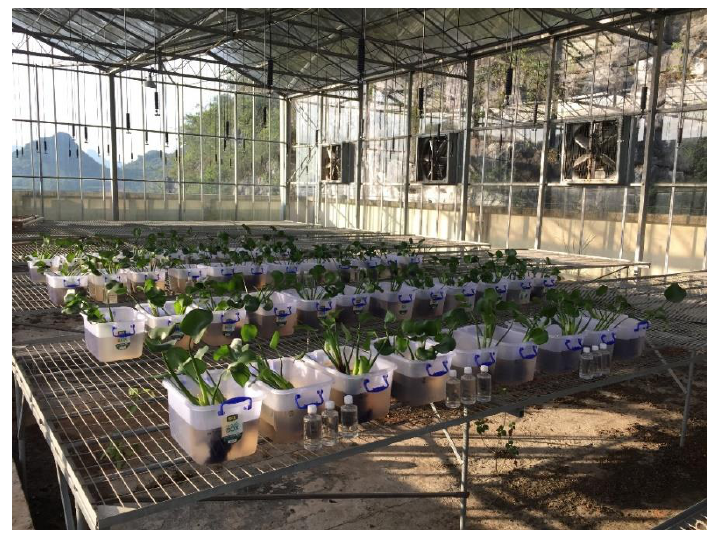
Figure 1. Experimental design.